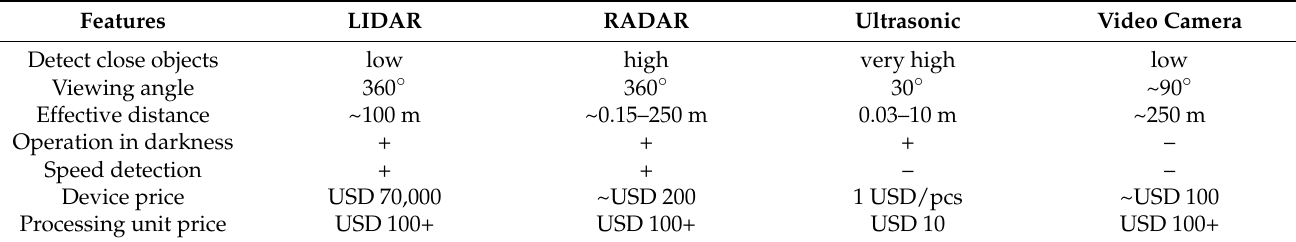
Table 1. Comparison of the obstacle detection